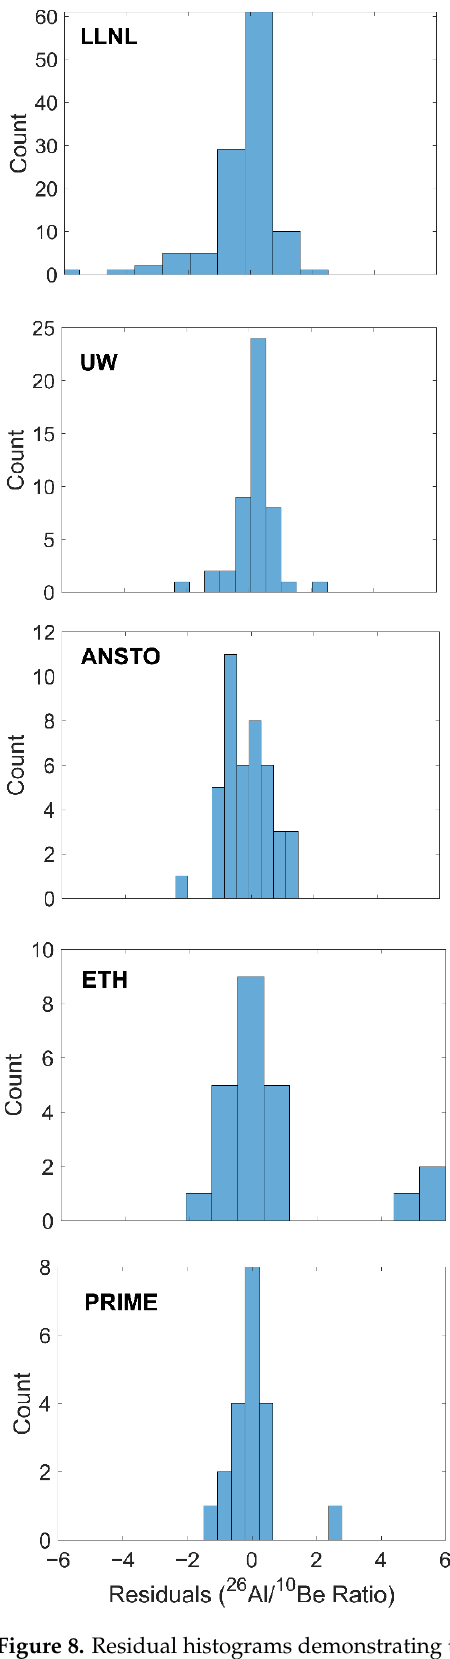
Figure 8. Residual histograms demonstrating the fit of our bi-variate model to samples from each of the major chemical processing labs.